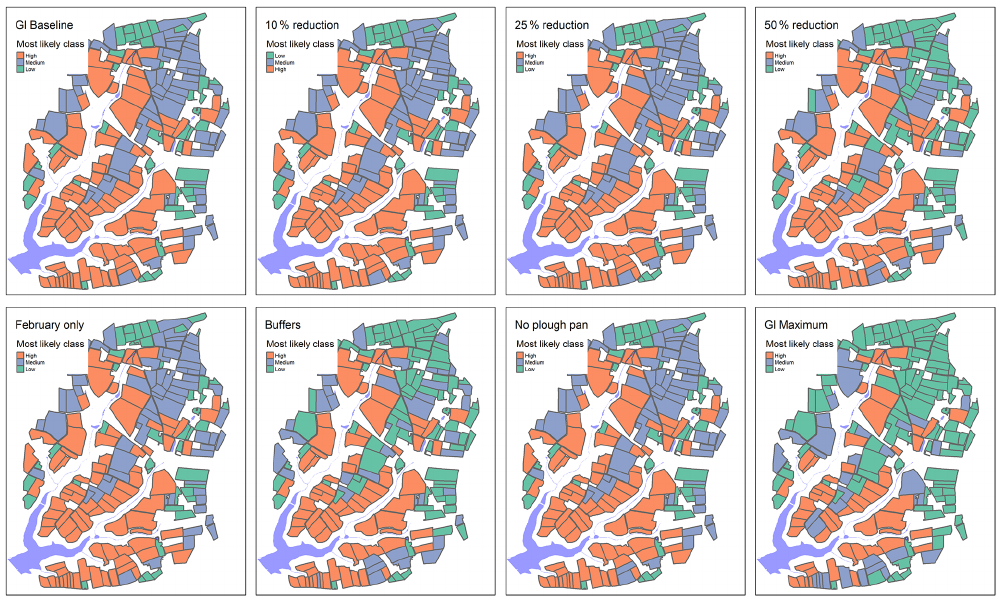
Figure B1. Most likely overland flow risk class for glyphosate under current application practices; with a 10%, 25%, or 50% reduction in the application rate; with a time shift of application to February; with additional field buffers; with no plough pan; and with all mitigation measures combined.